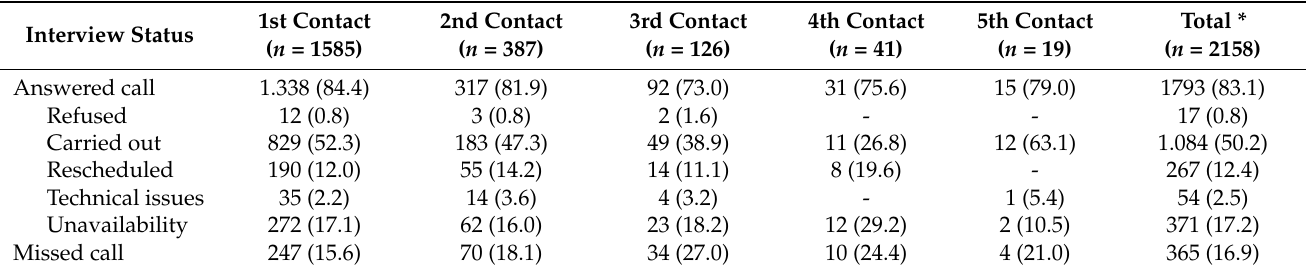
Table 3. Adherence process to the second 24H-DR measurement amongst the participants in the third wave of the ELSA-Brasil study. S ã o Paulo,